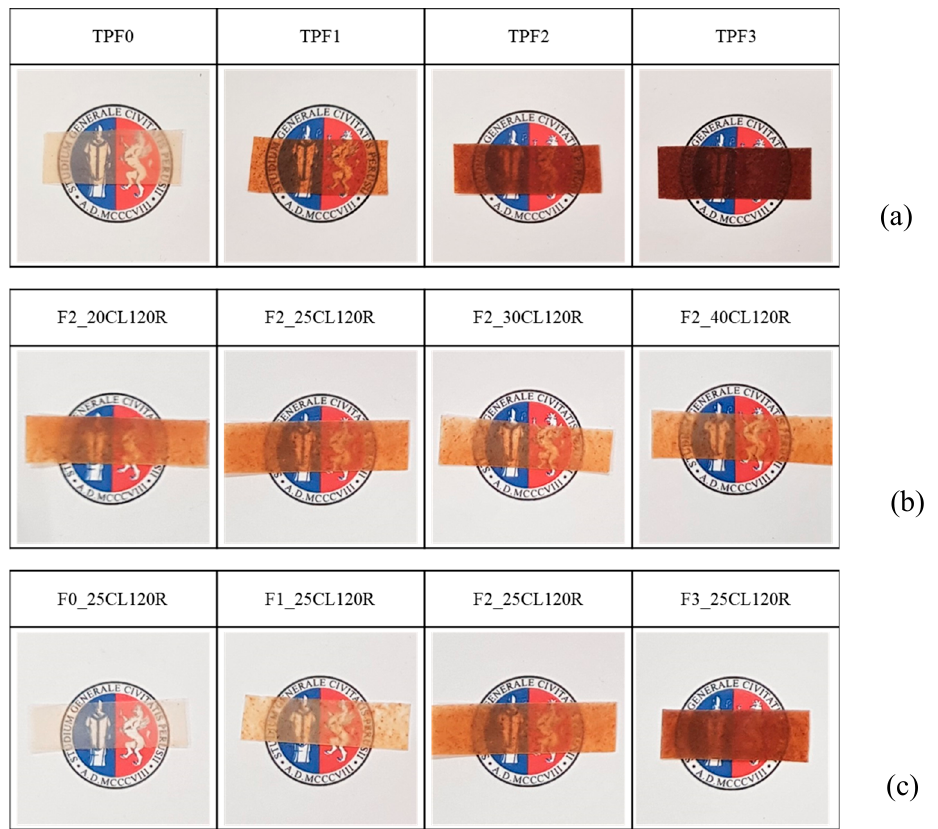
Figure 2. Visual observation of ( a ) thermoplastic wheat flour (TPWF) based films made with flours with increasing bran content (from F0 to F3), ( b ) F2 based films blended with 20, 25, 30 and 40% wt. of PC and ( c ) films based on plasticized F0, F1, F2 and F3 blended with 25% wt. of polycaprolactone (PCL).